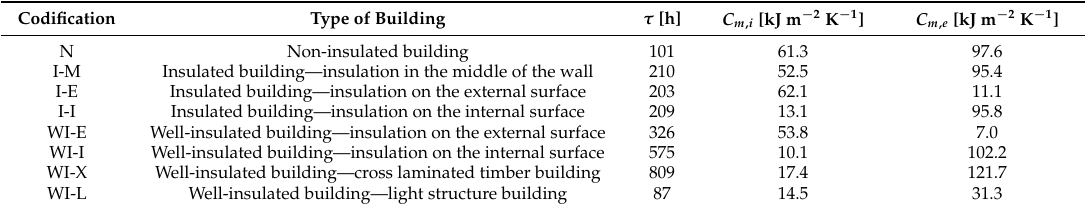
Table 1. Codification of the eight types of buildings simulated, time constant, and internal and external heat capacity of the outer walls.